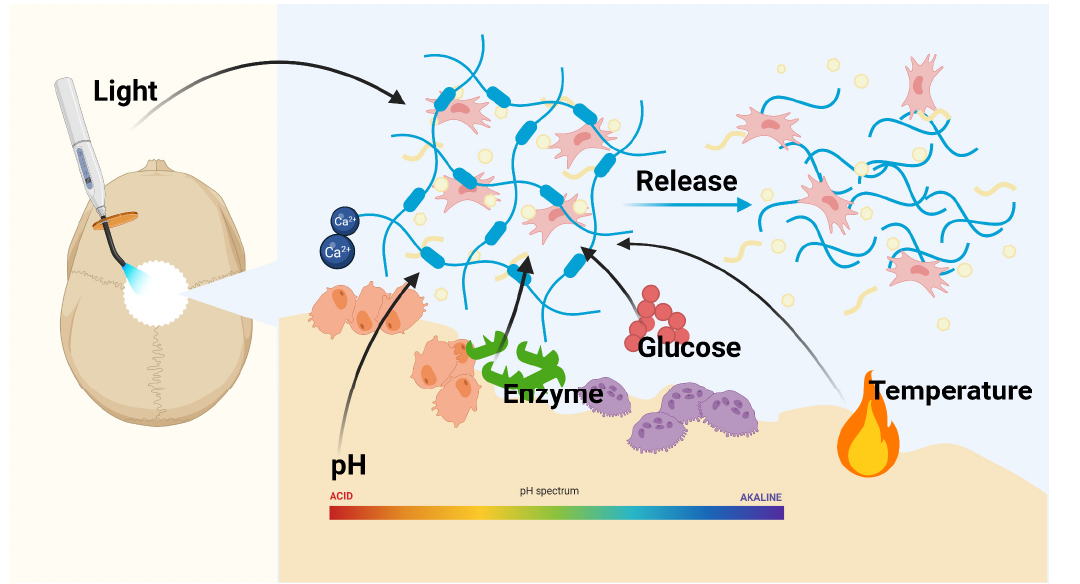
Figure 3. Schematic illustration of a variety of different stimulus-responsive drug delivery system. Stimulus-responsive hydrogels are subjected to specific stimuli, such as light, pH, enzymes, temperature and biochemical conditions, and decompose and deform in response to these stimuli, thereby releasing the cells and drugs. The figure was made with BioRender, accessed on 1 December 2022 (https://biorender.com/).